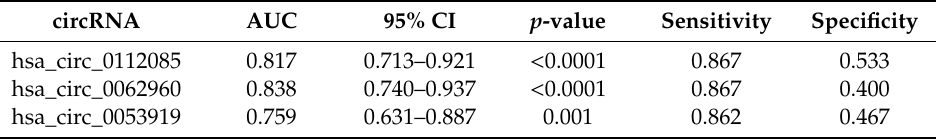
Figure 1. ( A ) Volcano plot of differentially expressed circular RNAs (circRNAs). Red plots represent overexpressed RNAs, and green plots represent downregulated RNAs with at least 2-fold change and corrected p < 0.05. ( B ) Heat map of the circRNA microarray profiles in the heart failure (HF) and control groups. The expression of circRNAs is hierarchically clustered on the y -axis, and blood samples are hierarchically clustered on the x -axis. Red indicates upregulated circRNAs, and green indicates downregulated circRNAs. Normal1–3 and HF1–3 are from control individuals and patients with HF, respectively. Table 3. Validation of the circRNAs in a large group by qRT-PCR (HF = 30, Healthy =